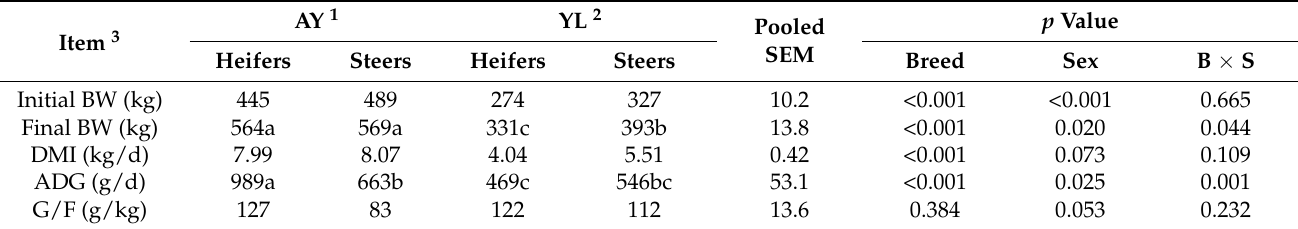
Table 1. The effects of breed and sex on growth performance of cattle.